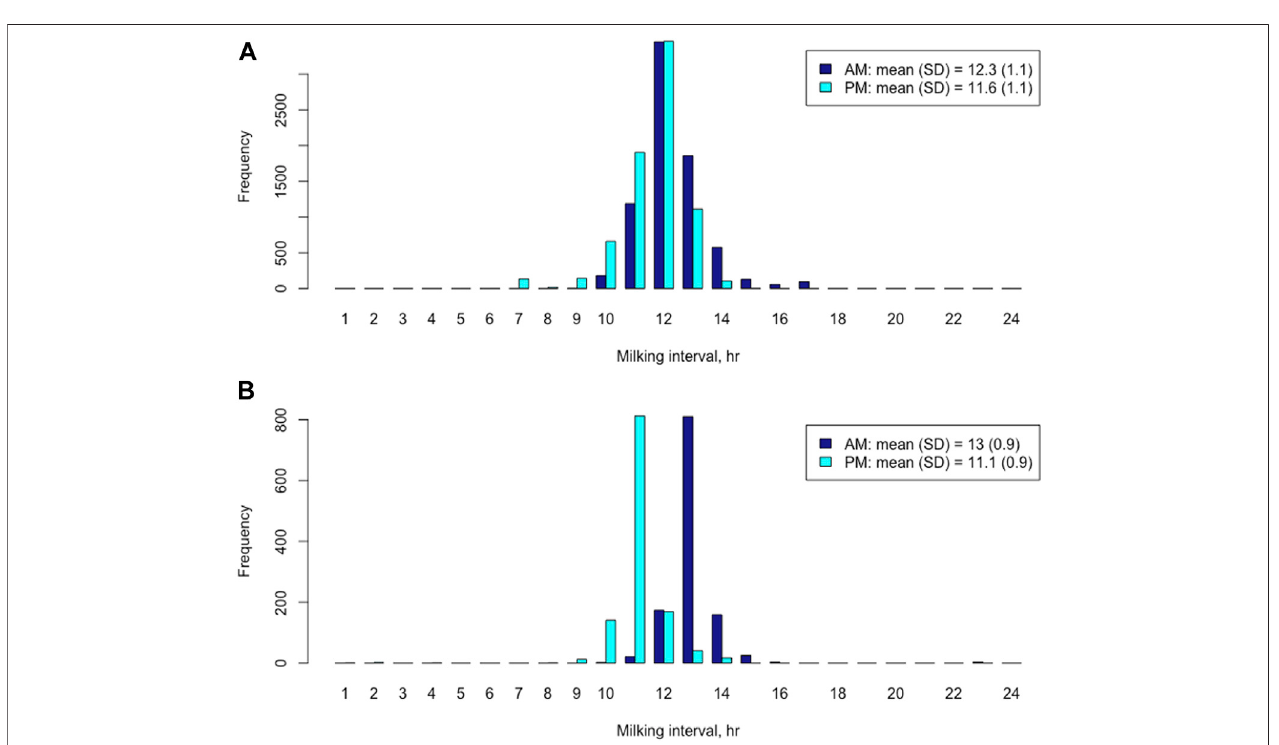
FIGURE 1 | Distributions of morning (AM) and evening (PM) milking interval time in Holstein cows (A) and Jersey cows (B) , respectively.